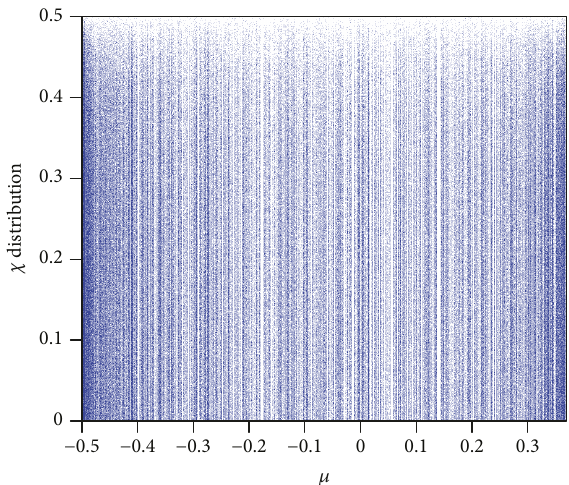
Figure 1: Distribution of the chaotic sequence X over the variables in the de fi nition domain with 1000